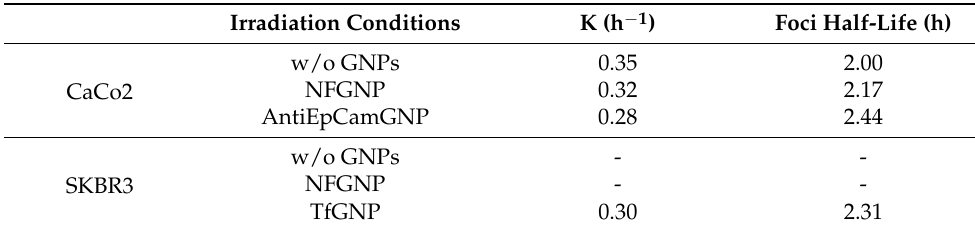
Table 2. Constant of the decay rate (K) and foci half-life for cells irradiated at 3 Gy in the three experimental conditions, in the absence of GNPs (w/o GNPs), in the presence of non-functionalized GNPs (NF-GNP) and in the presence of specifically targeted GNPs (AntiEpCamGNP and TfGNP for Caco2 and SKBR3 cells,